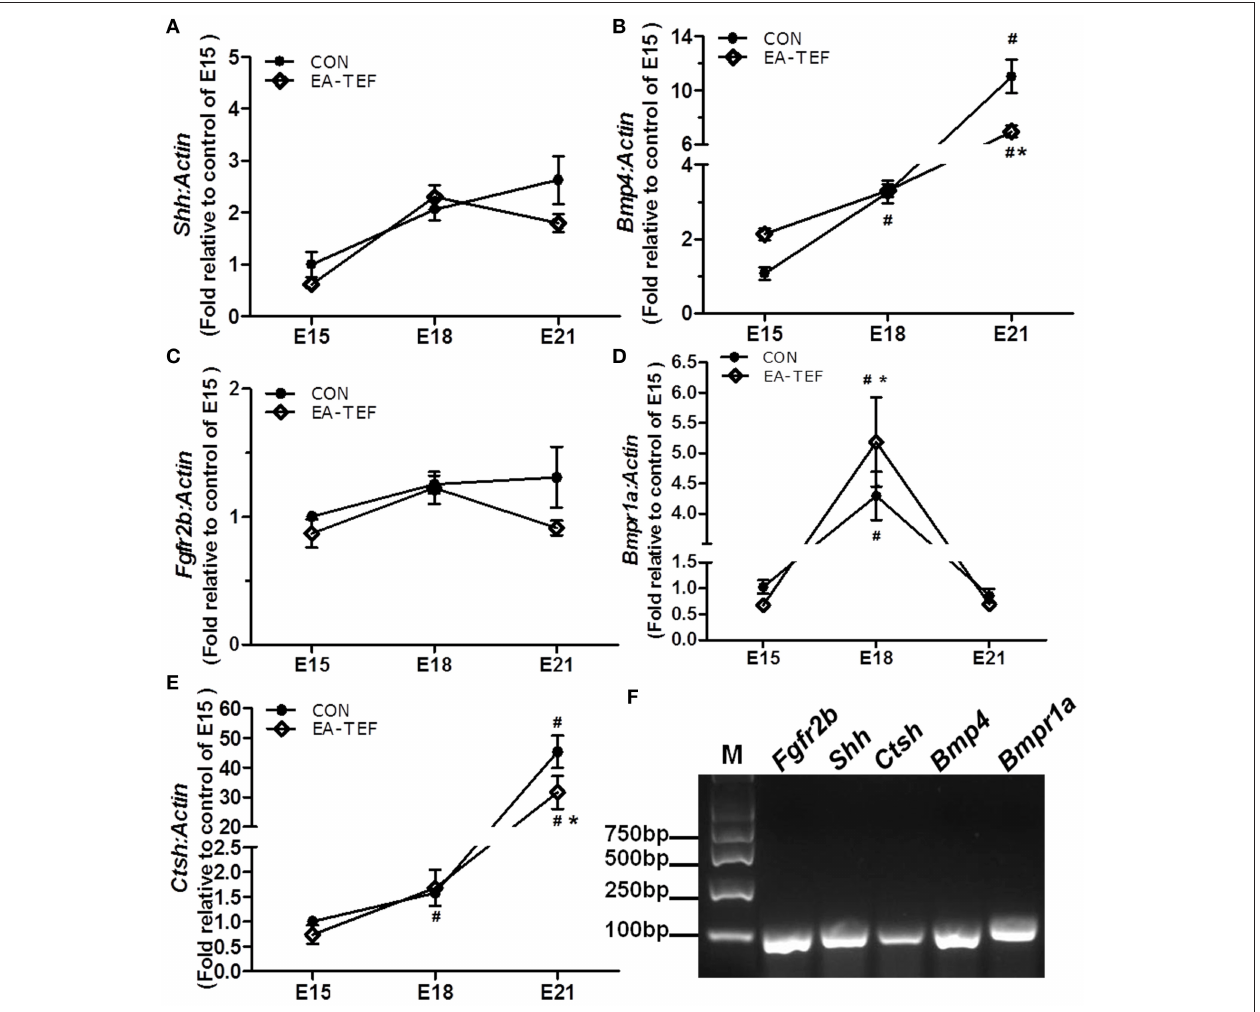
FIGURE 1 | Kinetics of Fgf10 signaling pathway factors in fetal lungs. (A–E) Shh, Fgfr2b, Bmp4, Bmpr1a, and Shh mRNA expression was assayed by quantitative PCR in EA and control lungs during the pseudoglandular (E15), canalicular (E18), and saccular (E21) stages, and results are shown relative to controls at E15. Data are means ± SEM, * P < 0.05, EA-TEF vs. age-matched controls between group; # P < 0.05, E18 or E21 vs. E15 within group (each n = 6). Due to the huge difference between the values in the same chart, the error bars of some of the points are too small to display. The data of Shh - EA-TEF-E15 is 0.618 ± 0.031; the data of Ffgr2b - CON-E15 is 1.002 ± 0.032; the data of Bmpr1a - EA-TEF-E15 is 0.679 ± 0.059. (F) Representative 2% agarose gel electrophoresis images of the amplicon size and the specificity of PCR